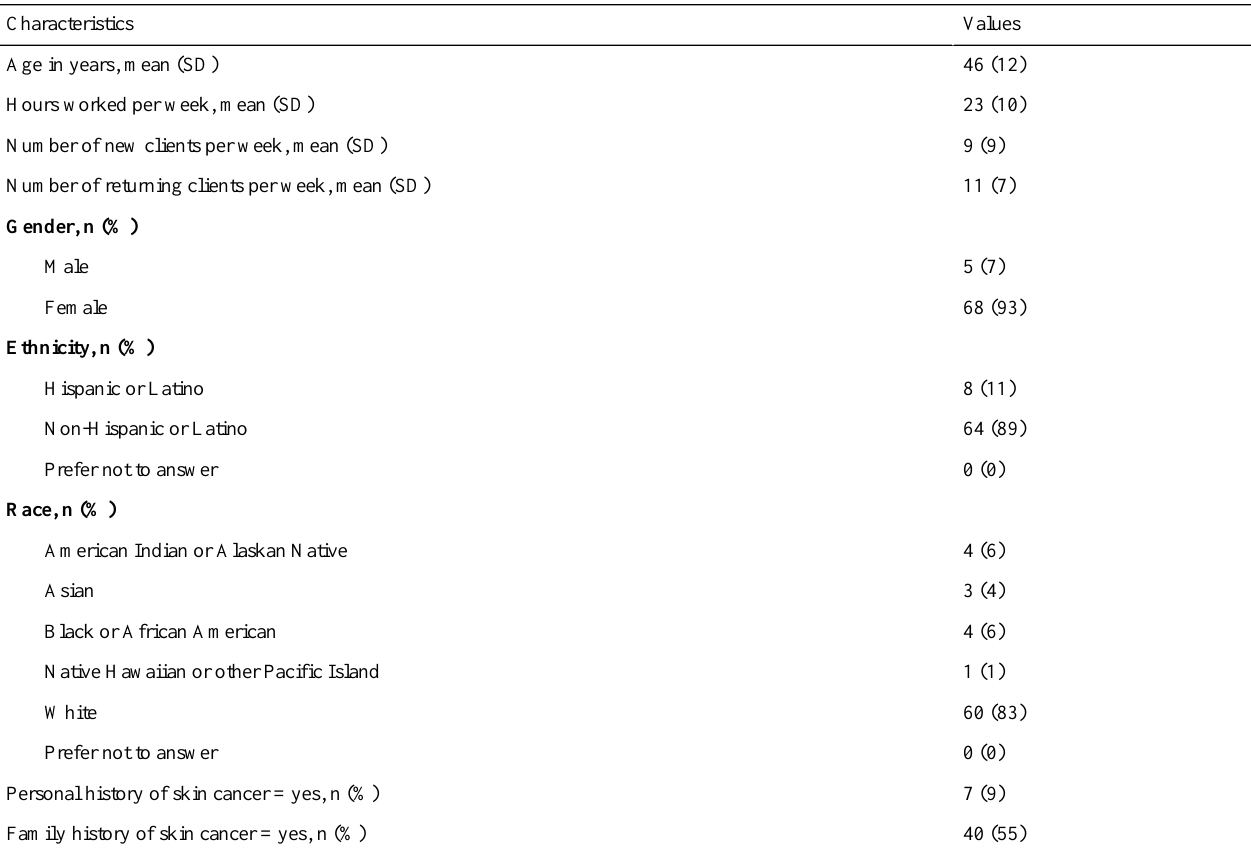
Table 1. Demographic characteristics of the sample